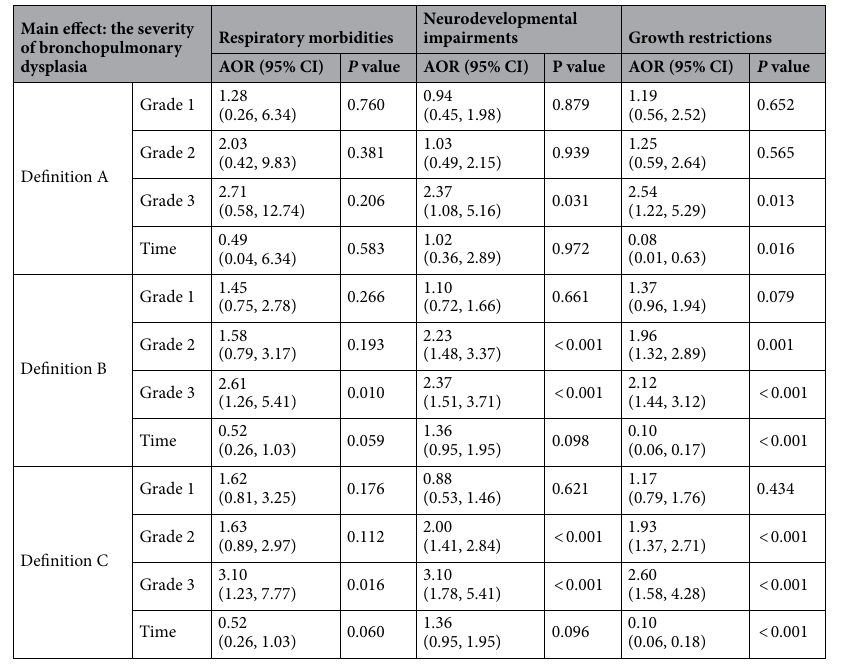
Table 5. Association of the severity of bronchopulmonary dysplasia and the risk of long-term outcomes over time per each definition. AOR adjusted odds ratio; CI confidence interval. ORs were adjusted for gestational age, small for gestational age, intraventricular hemorrhage (≥ grade 3), periventricular leukomalacia, necrotizing enterocolitis (≥ stage 2), retinopathy of prematurity (requiring surgery), and sepsis. A generalized estimating equation (GEE) method was applied to find the association between the severity of bronchopulmonary dysplasia and the risk of long-term outcomes over time per each